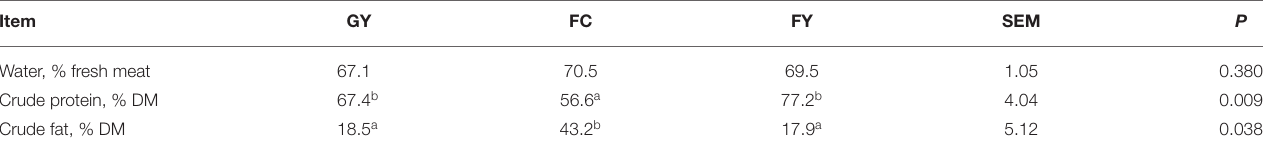
TABLE 5 | Chemical composition of Longissimus thoracis from GYs, FC, and FYs. Item GY FC FY SEM P Water, % fresh meat